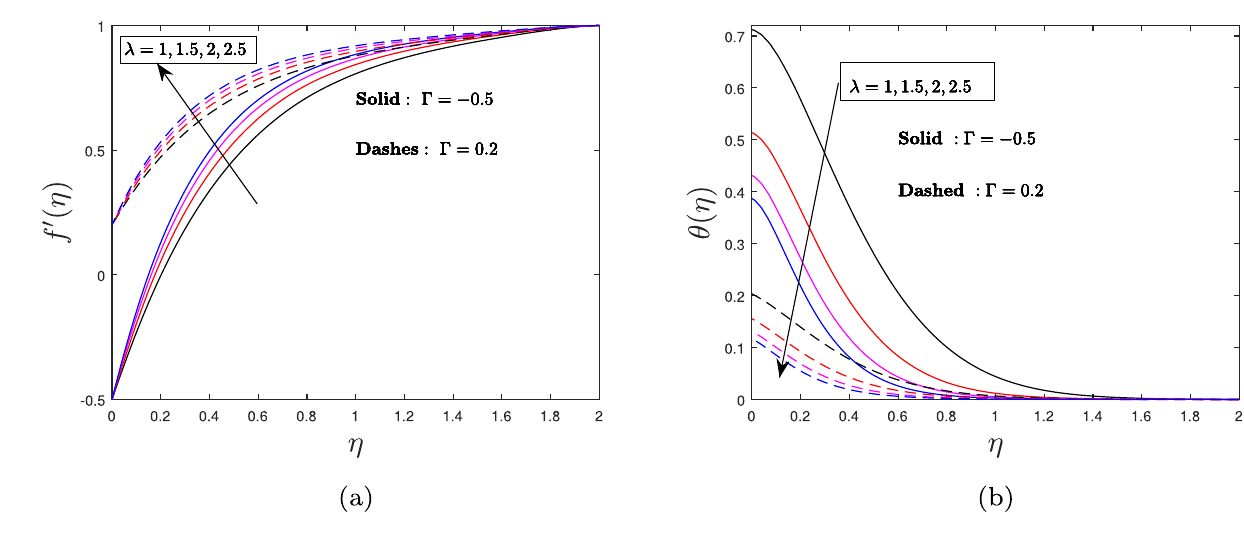
Figure 11: ( a ) Velocity and ( b ) thermal fi elds against di ff erent λ